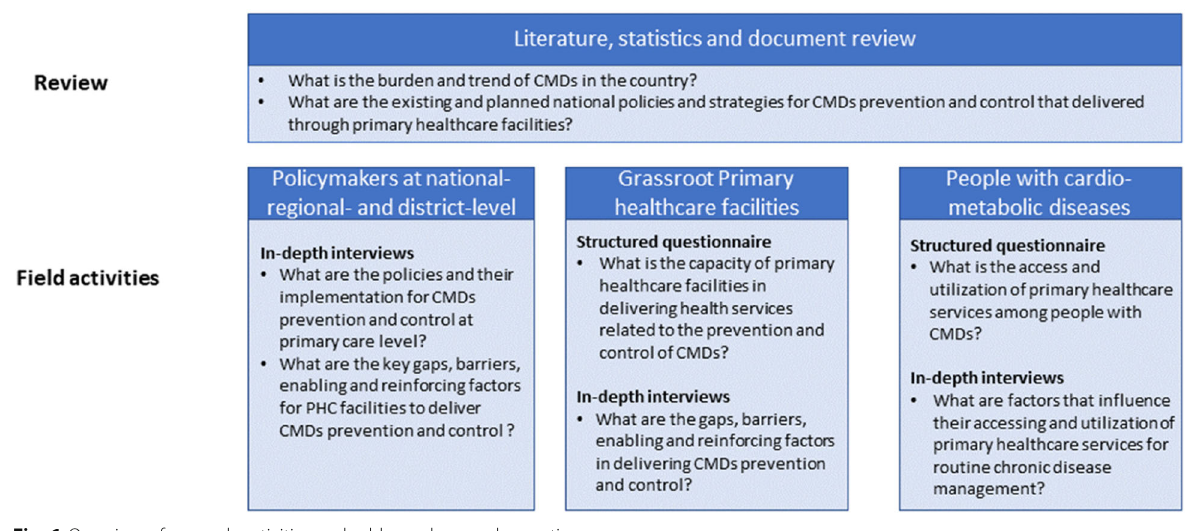
Fig. 1 Overview of research activities and addressed research